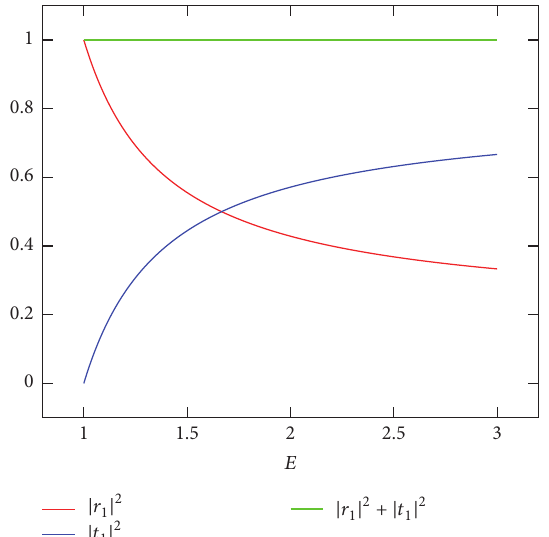
Figure 1: Plots of |𝑟 1 | 2 , |𝑡 1 | 2 , and |𝑟 1 | 2 + |𝑡 1 | 2 as energy